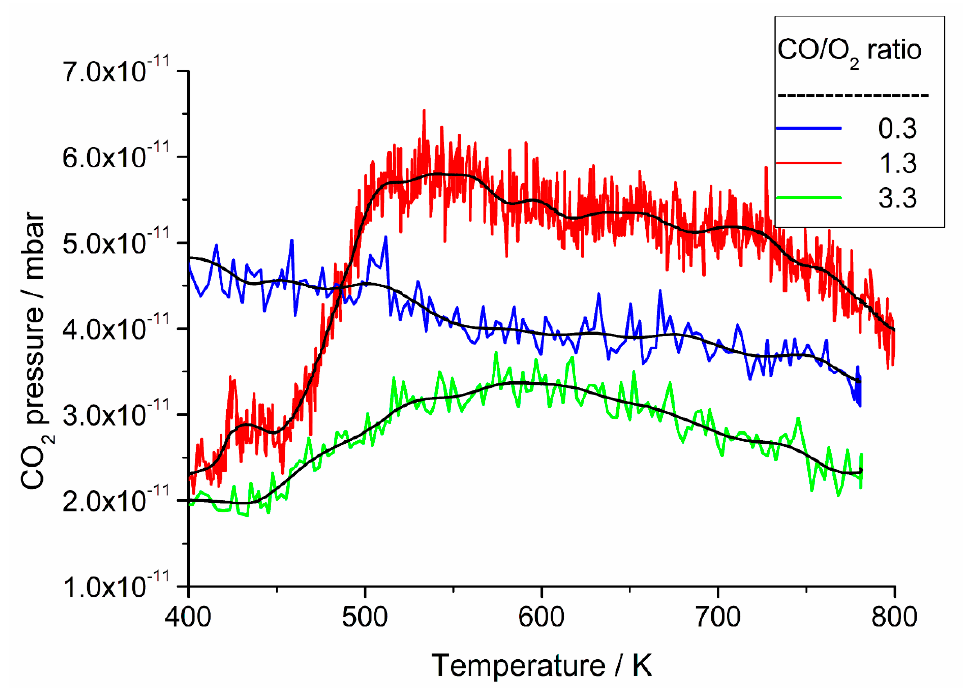
Figure 11. Pseudo-steady-state CO 2 evolution while ramping the surface temperature at 4 K / s. The crystal was supplied with a constant flux of CO and oxygen from the molecular beam. CO / O 2 ratios as in Figure 10.